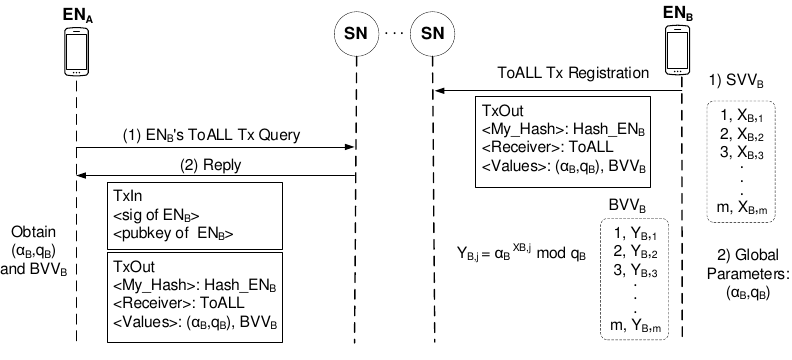
Figure 7. Tx information access by Query/Reply